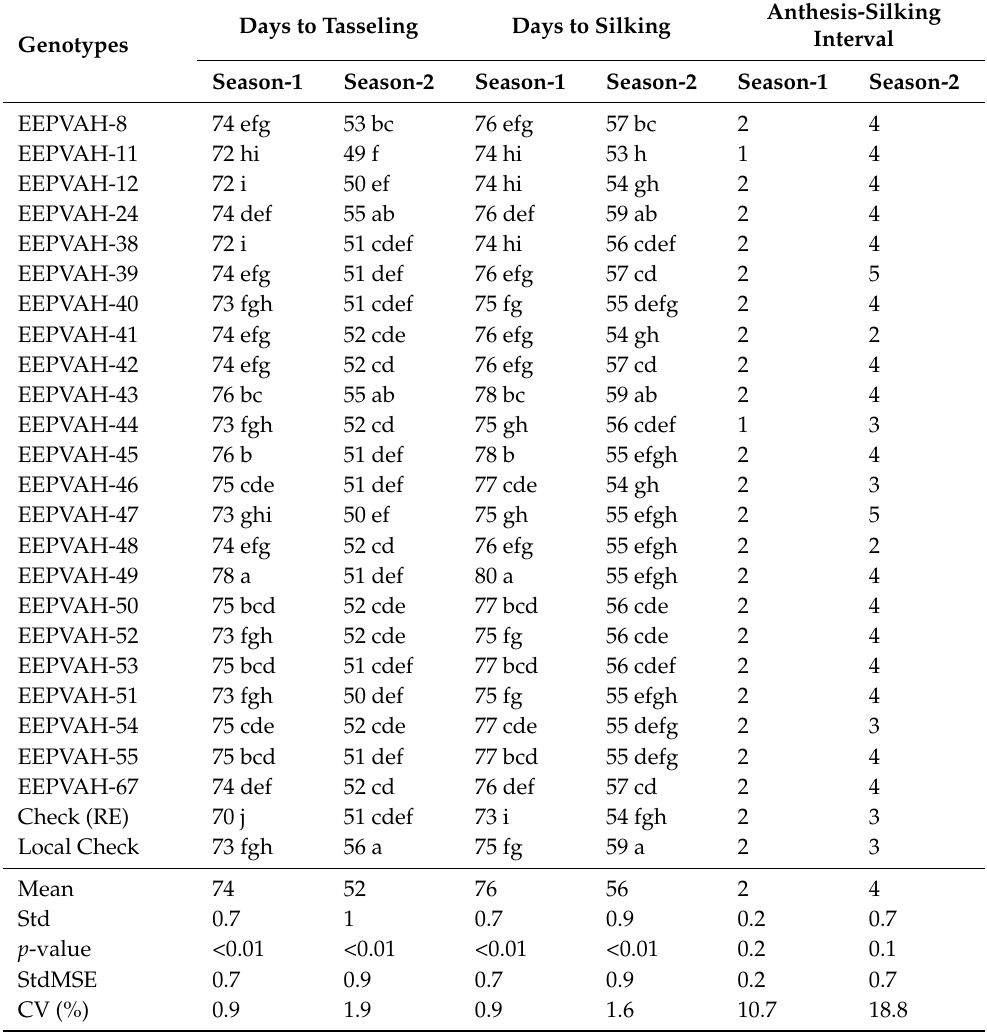
Table 2. Phenological traits of extra early provitamin A biofortified maize genotypes recorded from two contrasting